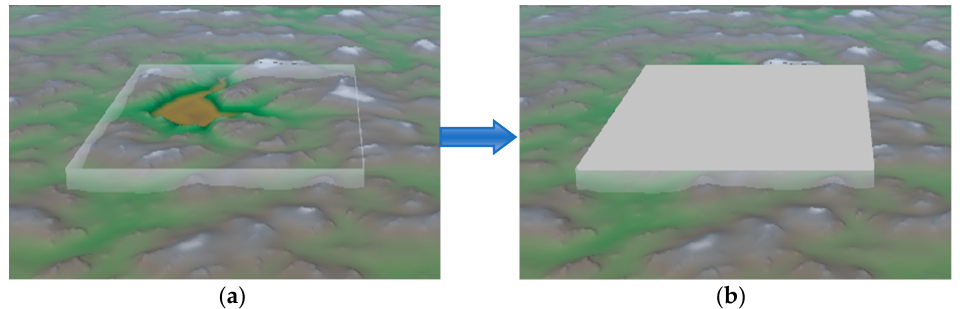
Figure 3 clarifies the gradient map auto-calibration (GMAC) operation on SGBIN clusters to achieve zero-o ff sets by subtracting all the gradients from all the sensor values in the time series, which reduced computation complexities. Appl. Sci. 2019 , 9 , x FOR PEER REVIEW